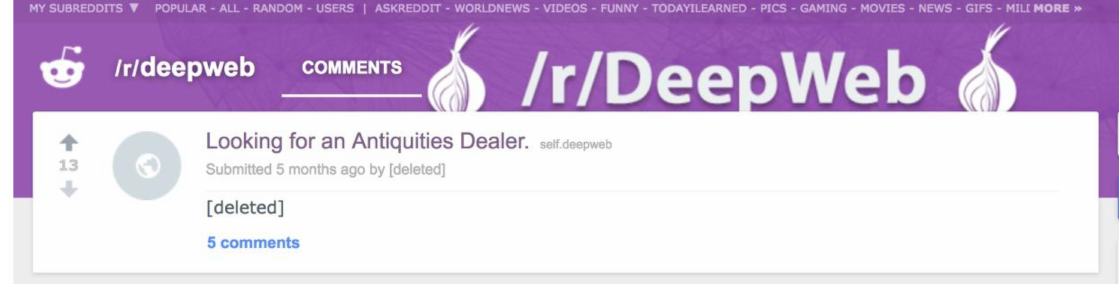
Figure 10. Screen grab of the subreddit for DeepWeb (r/deepweb) with a request for an antiquities dealer from a since-deleted account. (Screen grab by author 2018).